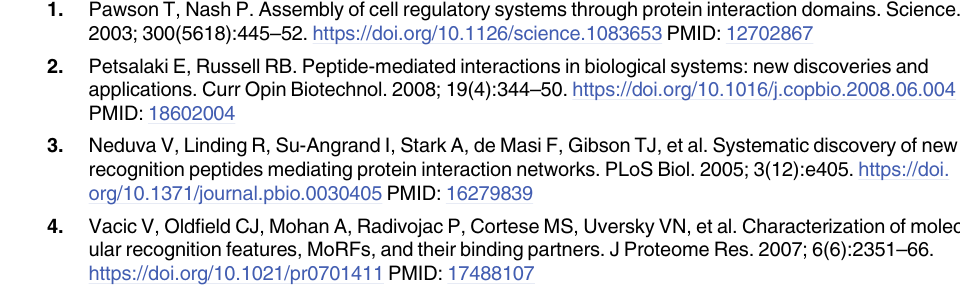
S1 Table. Details of the datasets of peptide-protein complexes, including modeling results for PIPER-FlexPepDock and other peptide docking protocols (accompanies Table 1). (A) Calibration set (n = 9 complexes); (B) Non-redundant set (n = 27 complexes); (C) Redundant set (n = 42 complexes). S2 Table. Median fragment-native Backbone-RMSD values for the PeptiDock set com- plexes obtained using Rosetta fragment picker and the motif-based fragment generation approach used in PeptiDock